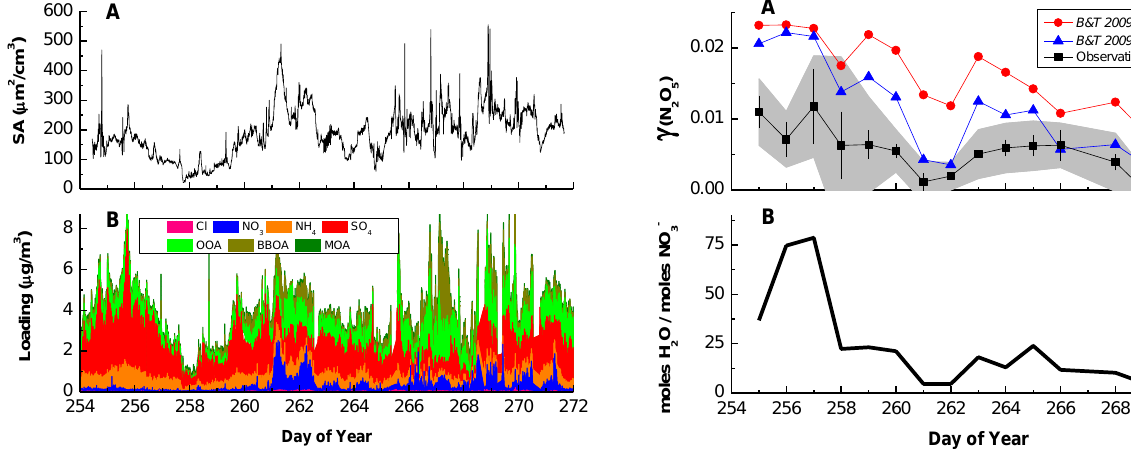
Fig. 4. (A) Observed (black squares) and parameterized (blue trian- gles and red circles) N 2 O 5 reaction probabilities, γ (N 2 O 5 ) , binned to a 24-hour time base for the entire study. The gray shaded area represents the estimated instrumental error, and the vertical bars represent the standard deviation (1 σ) of the points in each bin. The red circles show the predictions of the full parameterization while the blue triangles show the predictions from the parameterization neglecting the chloride dependence. (B) 24-h bins of the mole ra- tio of particulate water predicted by the AIM model and the AMS reported nitrate